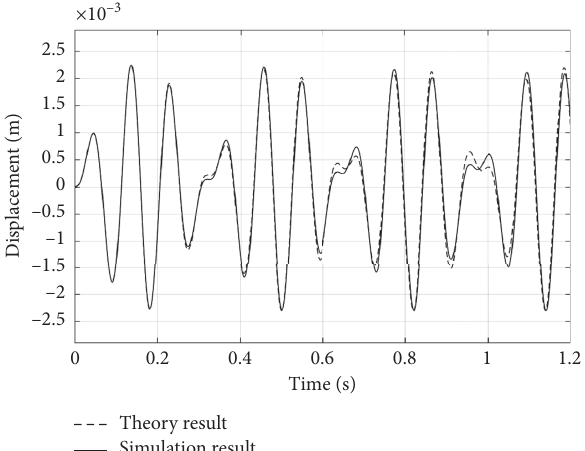
Figure 8: Comparison between theoretical and FE results without beam DVA, 1-inch pipeline, with an excitation frequency of 22Hz.